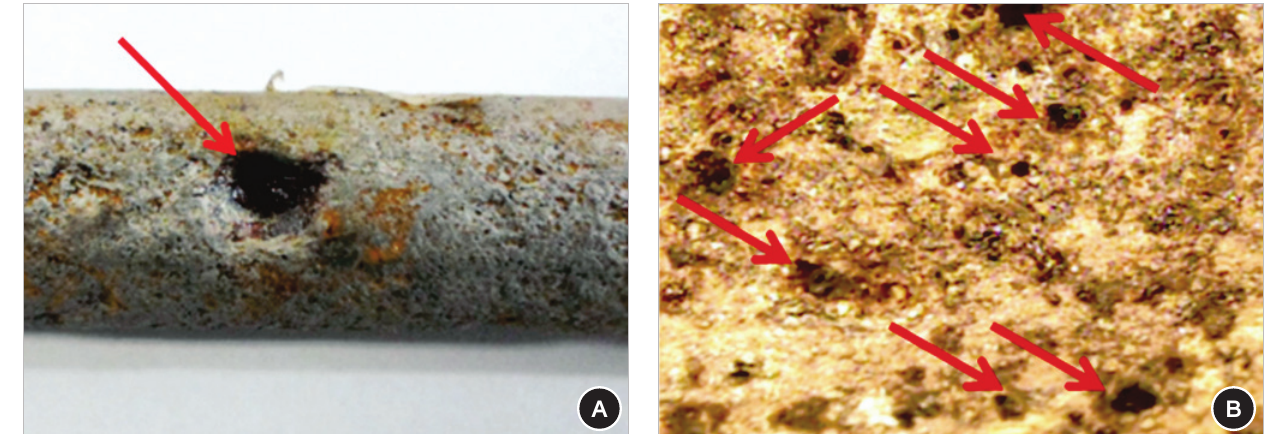
(a) Pit image obtained by visual inspection; (b) Micrographs showing the presence of pits in a certain region of a test specimen. Magnification of 10x